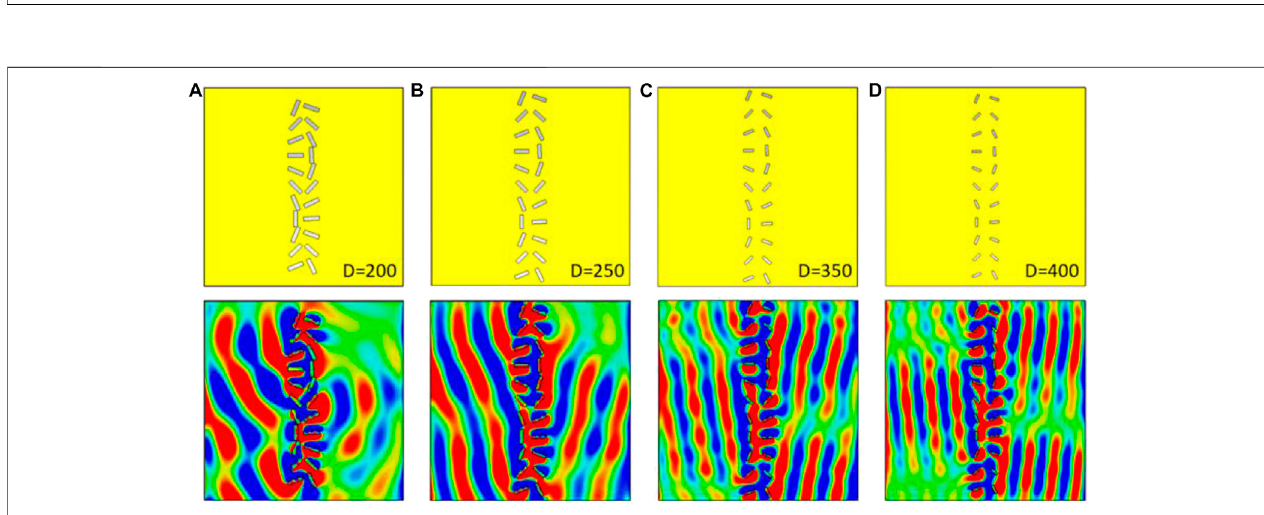
FIGURE 3 | Calculated E z - fi eld distributions of ZTSW under normal incidence of LCP at 0.496 THz with a distance D of (A) 200 μ m, (B) 250 μ m, (C) 350 μ m, and (D) 400 μ m. The top panel is a schematic of the structures.